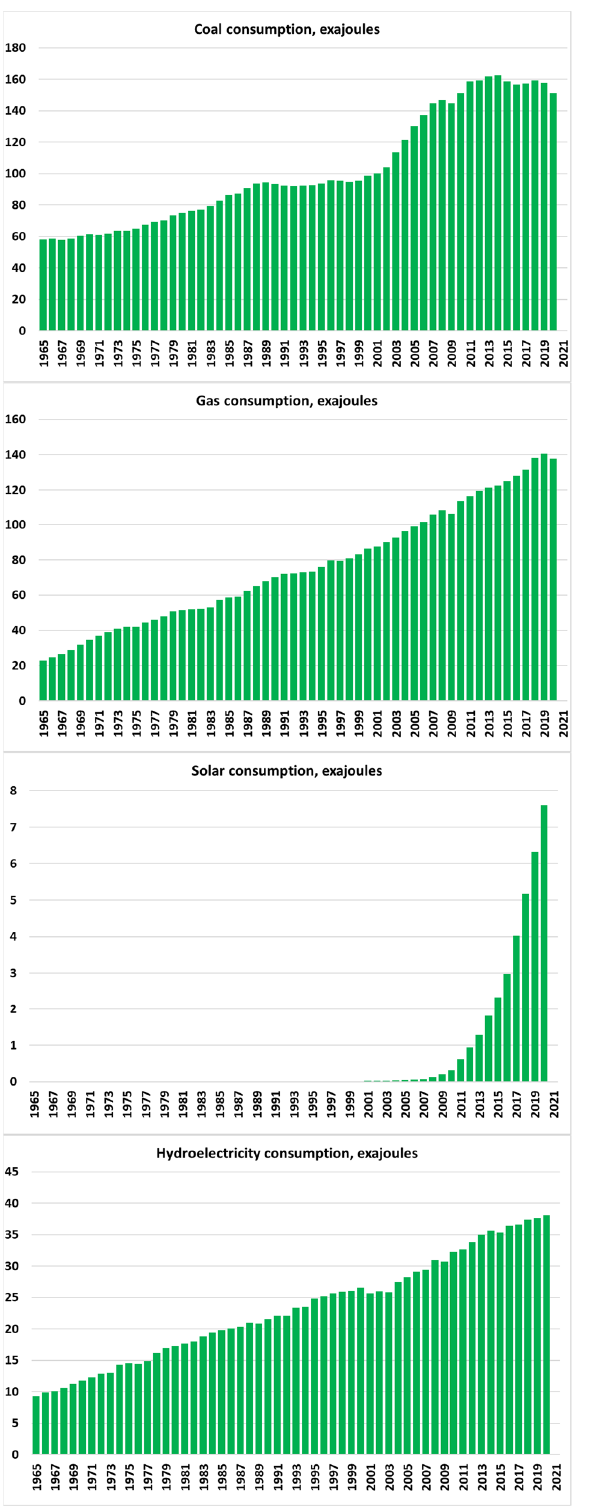
Figure 11. Energy consumption by fuels, exajoules [5].